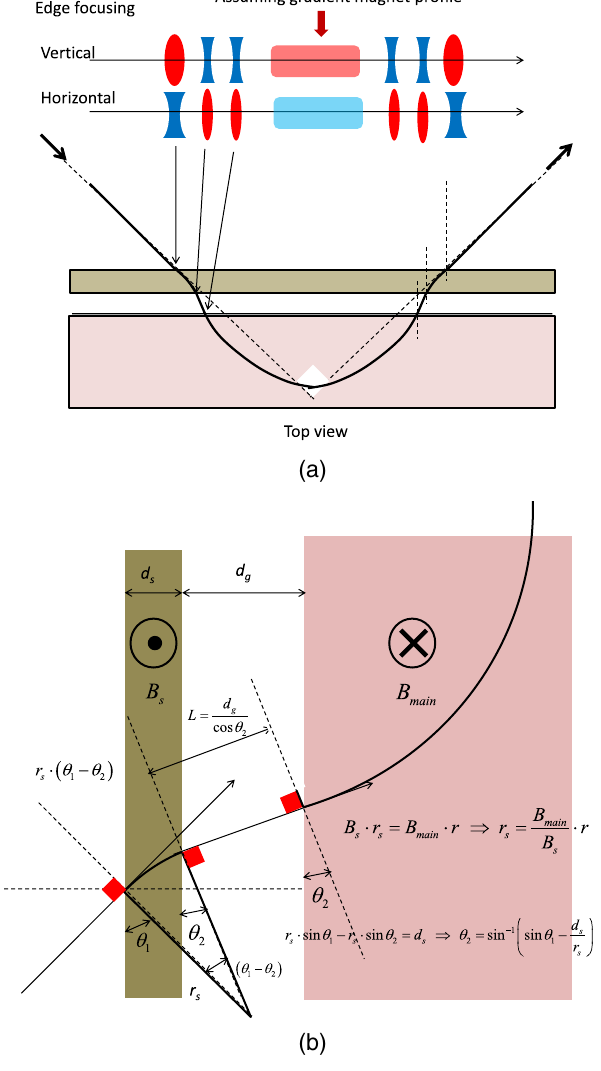
FIG. 4. (a) Top view of the bending magnet with characteristics of the edge focusing. Red and blue in the upper figure implies focusing and defocusing, respectively. (b) Orbit geometry near the magnet entrance, where rectangular magnetic field profiles with the uniform flux density of B s and B are assumed. main